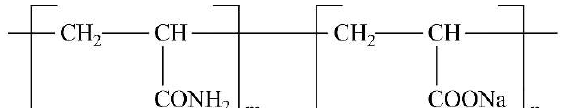
Figure 8. Structure of polyacrylamide (HPAM) molecular chain [40].